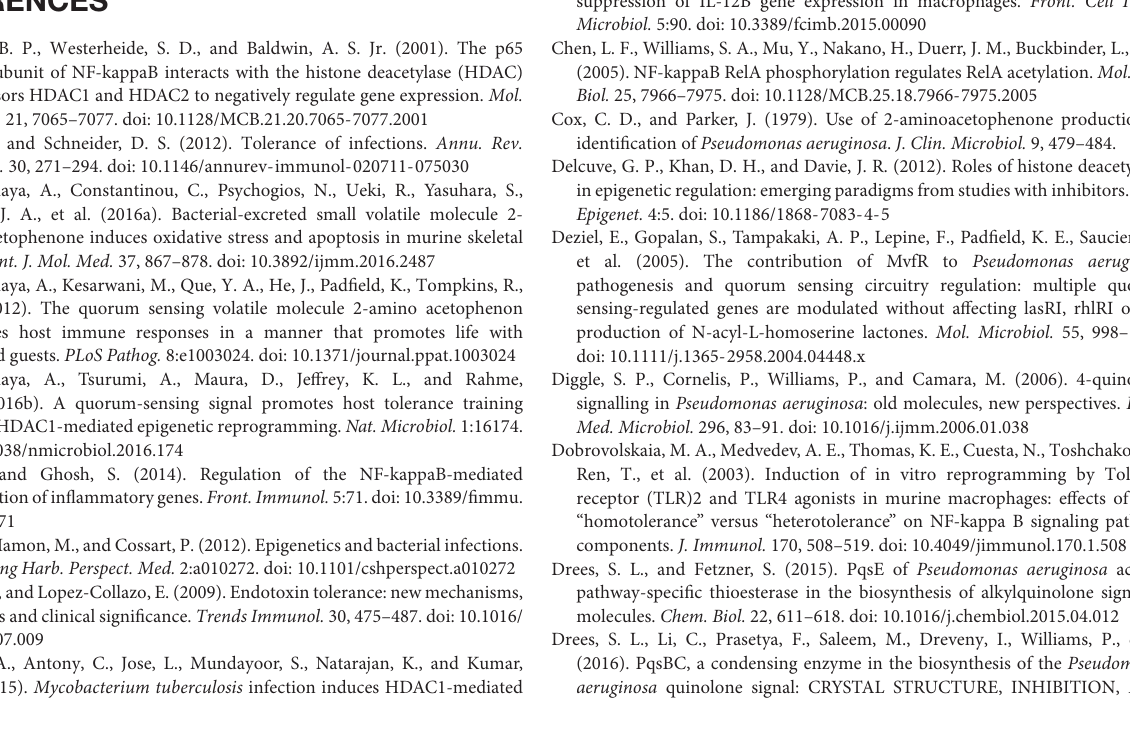
FIGURE S1 | Human monocyte cell viability in presence of HAT inhibitor C646. MTT assay measuring viability in THP-1 cells following treatment with increasing concentrations of C646. Cells were exposed to C646 for 24 h ( n = 3; means ± SDs). FIGURE S2 | Acetylation of CBP/p300 is modulated by 2-AA. Western blot analysis showing decreased CBP/p300 acetylation in 2-AA-tolerized mouse